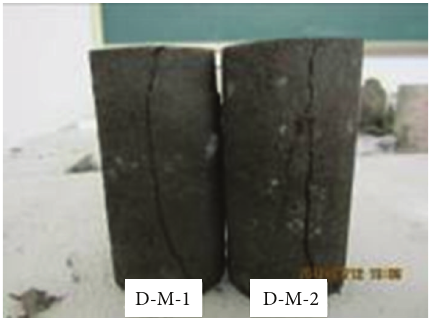
Figure 4: Splitting failure modes of coal samples under uniaxial compression.